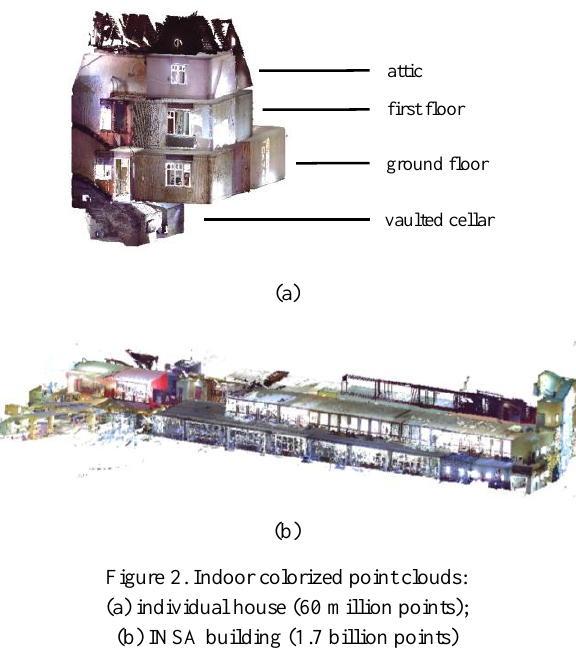
Figure 2. Indoor colorized point